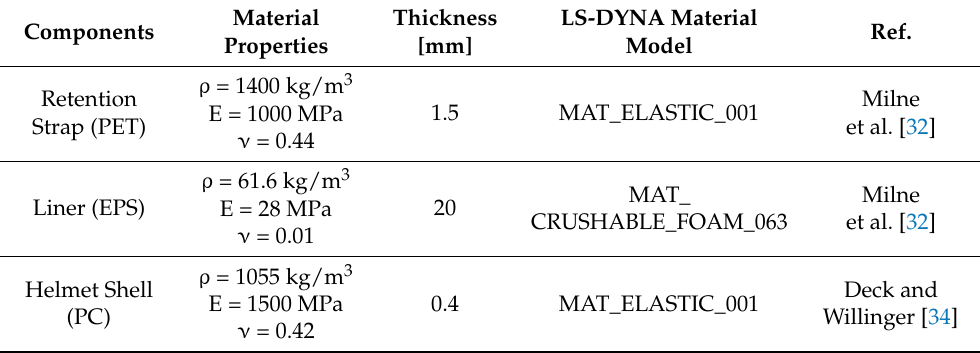
Table 2. Material properties of various components in the airbag–helmet–headform